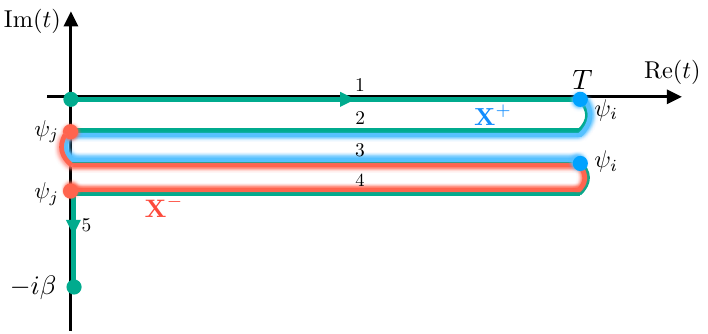
Figure 2 . The support along the SK contour of forward and backward shocks, sourced by pairwise operator insertions at ˆ t 1 = ˆ t 2 = 0 and ˆ t 3 = ˆ t 4 = T